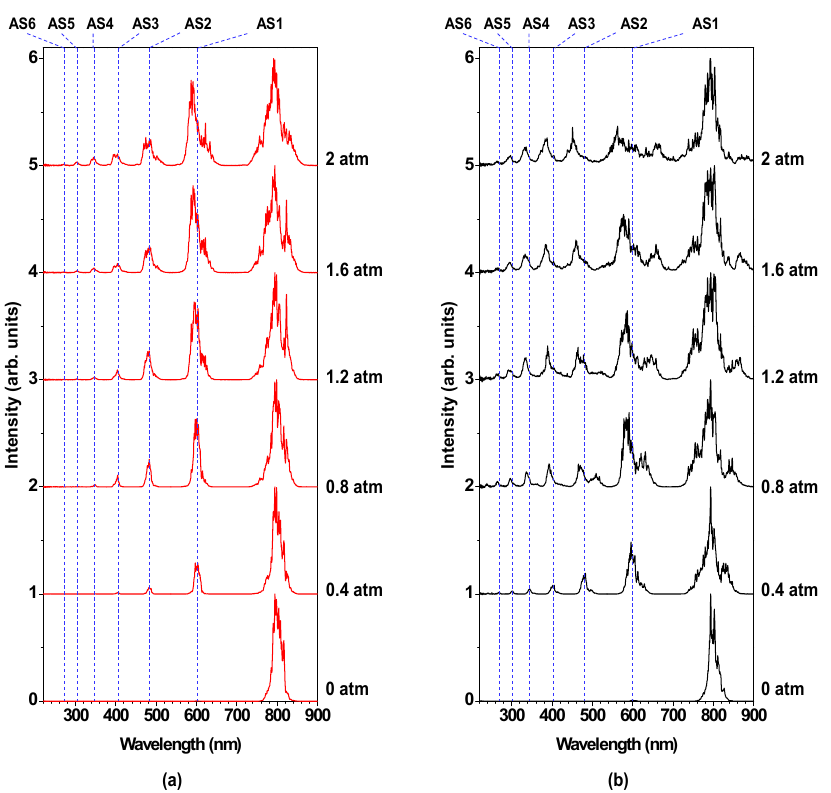
Figure 2. The spectra of output beams at different hydrogen pressures. ( a ) Gas cell; ( b ) Hollow fiber.